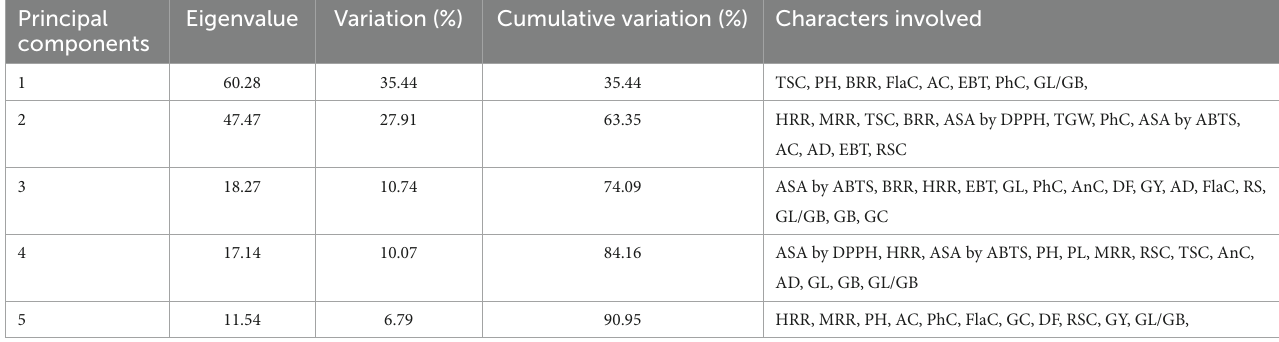
TABLE 4 Percent variance of first five principal components for quantitative traits of 20 rice genotypes selected from C14-8 population. Principal components